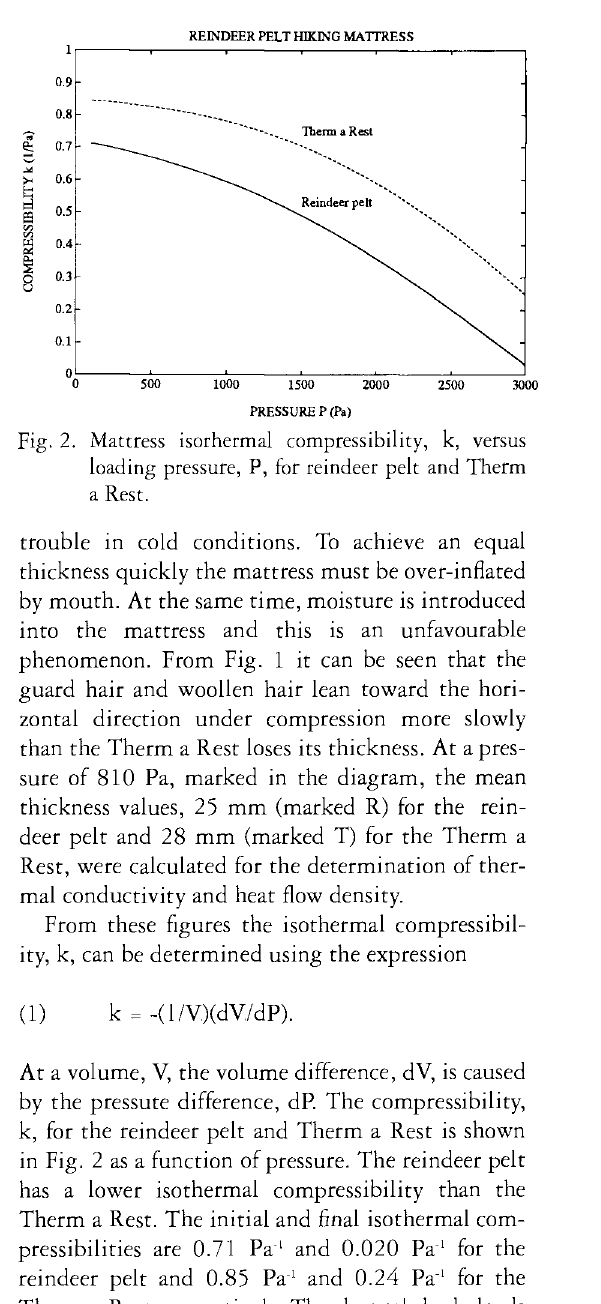
Fig. 1. Mattress thickness, Mt, versus loading pressure, P, for reindeer pelt. Graphs for Therm a Rest are given as